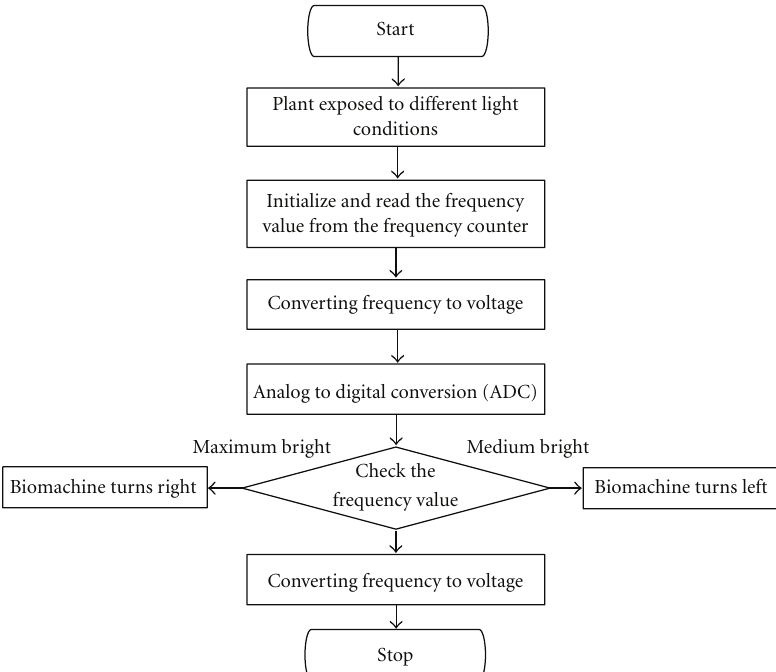
Figure 12: Flow chart for the movement of the bio-machine.